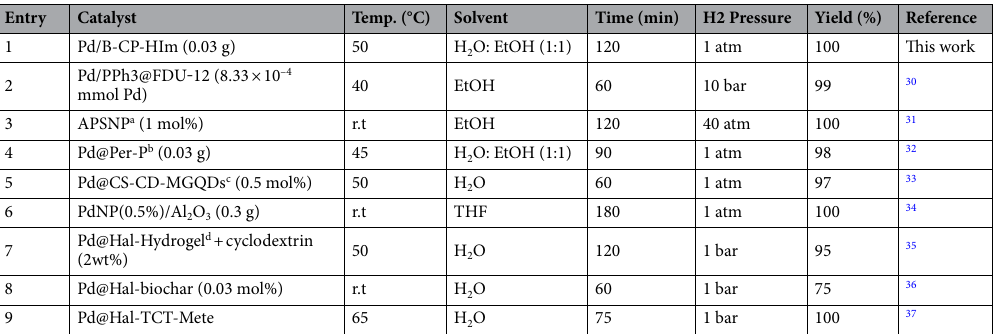
Table 3. Comparison of reaction condition and yield of various catalysts for hydrogenation of nitrobenzene. a Activated palladium sucrose nanoparticles. b Pd on composite of perlite and polymer. c Pd on composite